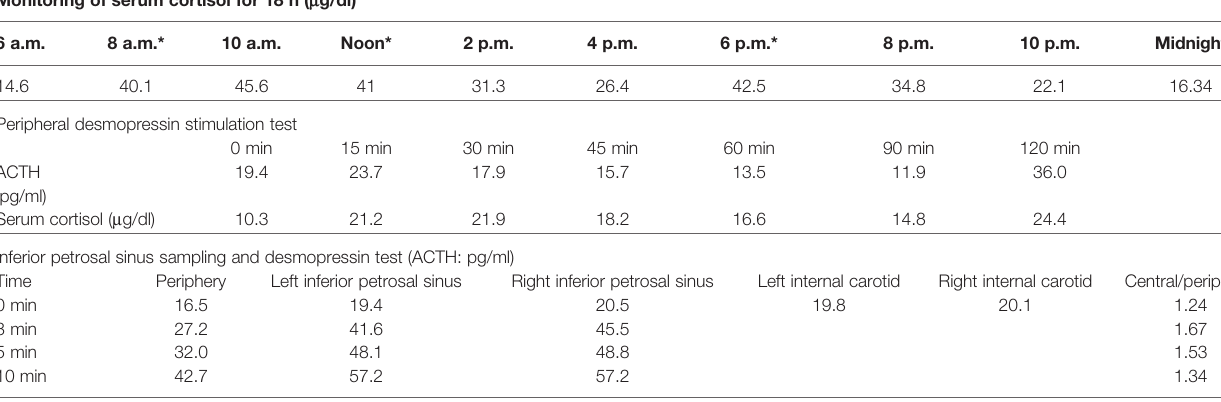
TABLE 2 | Laboratory results of the patient. Monitoring of serum cortisol for 18 h ( m